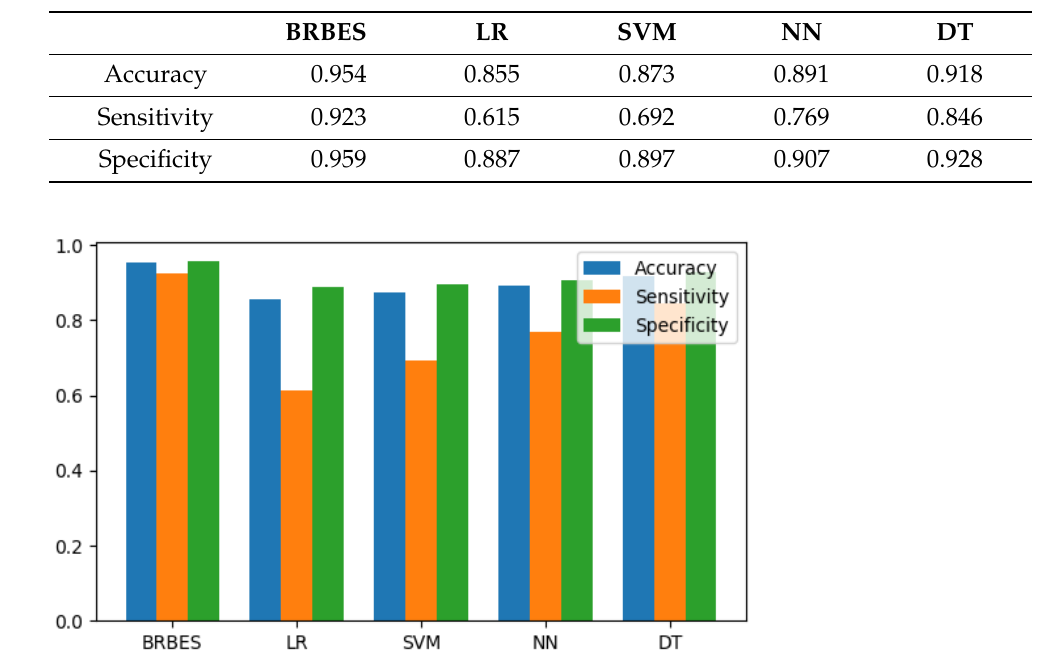
Figure 5. Comparison of accuracy, sensitivity, and specificity for BRBES (T-CBRB), LR, SVM, NN, and